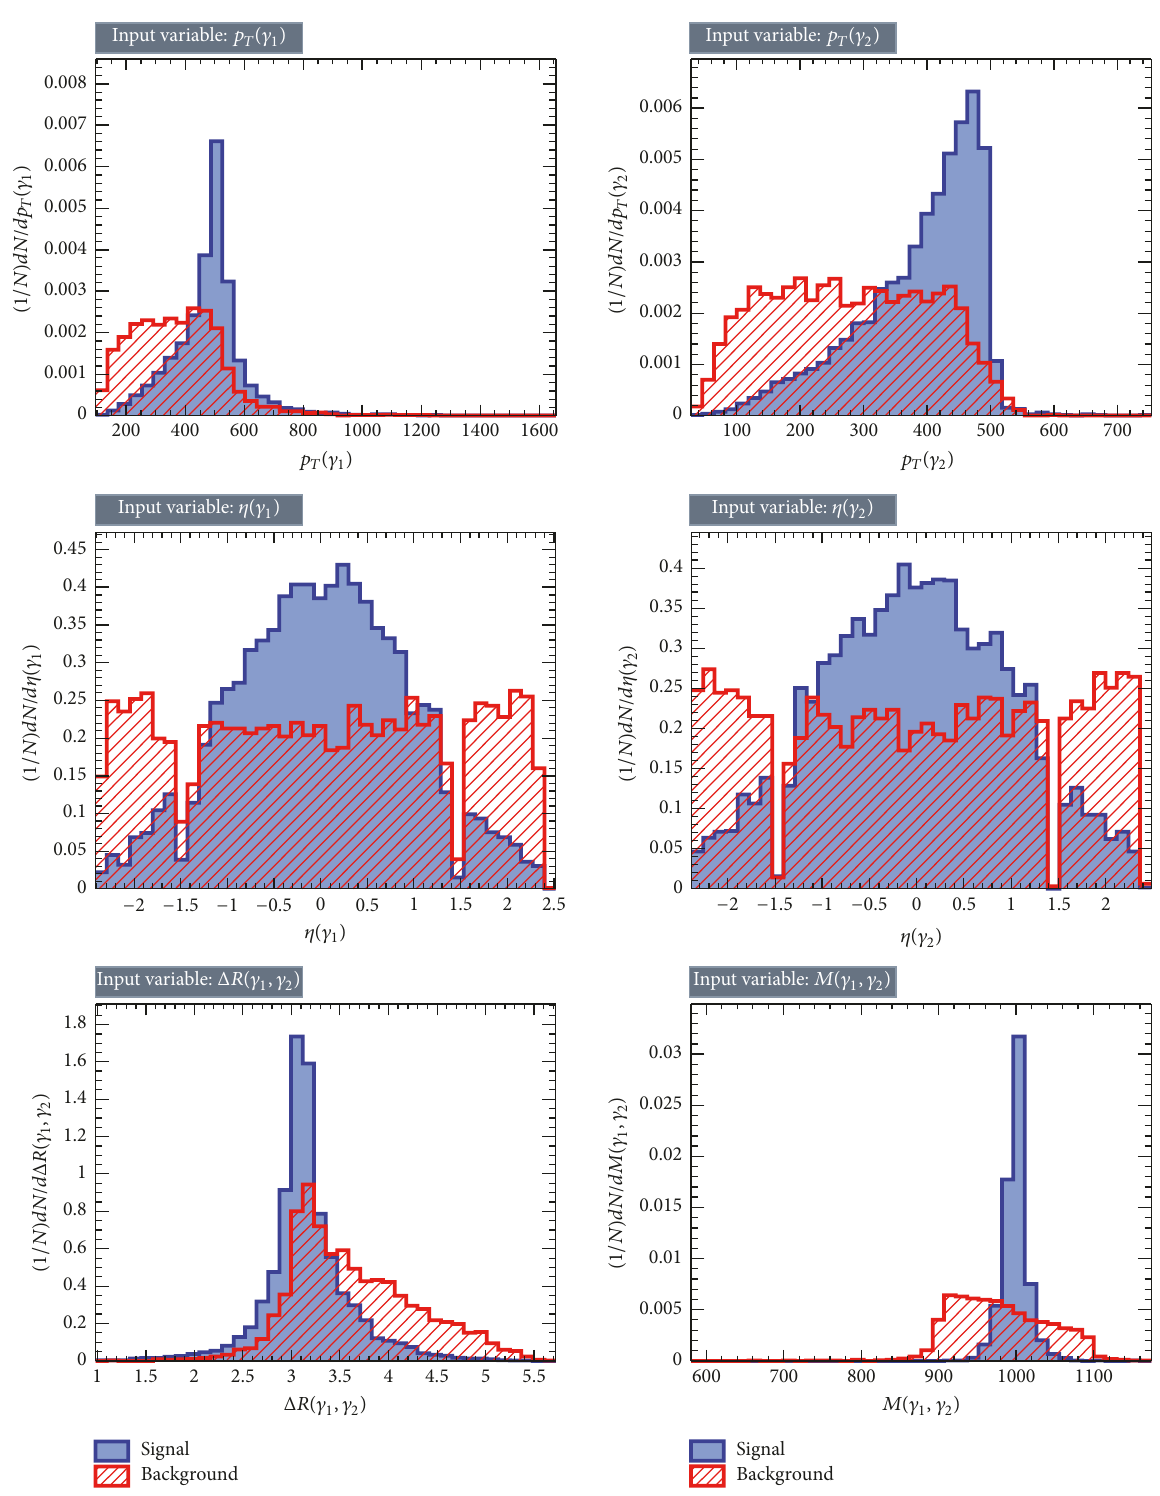
Figure 5: Signal (blue) and background (red) distributions of the input variables used for MVA. These distributions are generated for 𝑀 S = 1 TeV assuming Γ = 1 GeV. We do not present the jet multiplicity distribution here since it has the smallest RI in the MVA as shown in S Table 2 and therefore the 𝑁 jet distribution would not differ much for the signal and the